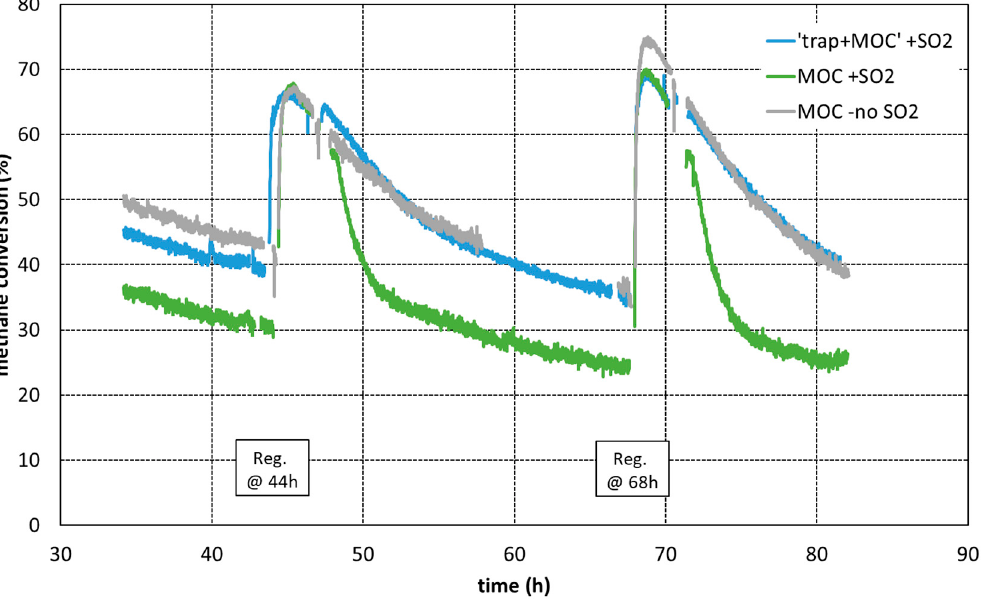
Figure 4. Methane conversion based on two simultaneously measuring FTIRs.